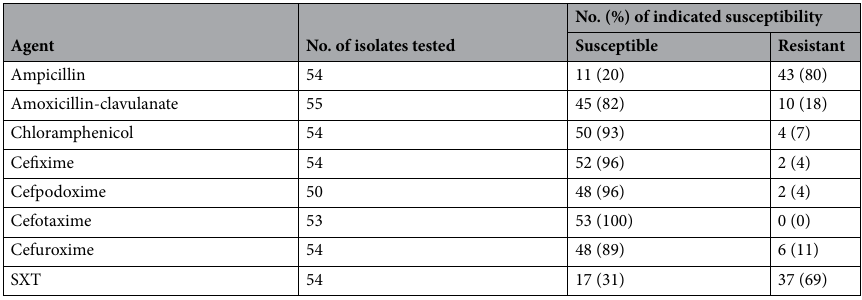
Table 2. Antimicrobial susceptibilities of Haemophilus influenzae isolates recovered from conjunctiva or ear discharge using the disk diffusion method * . SXT, Trimethoprim/sulfamethoxazole. *One child received both conjunctiva and ear discharge culture examination, and both yielded Haemophilus influenzae with the same antimicrobial susceptibility pattern.